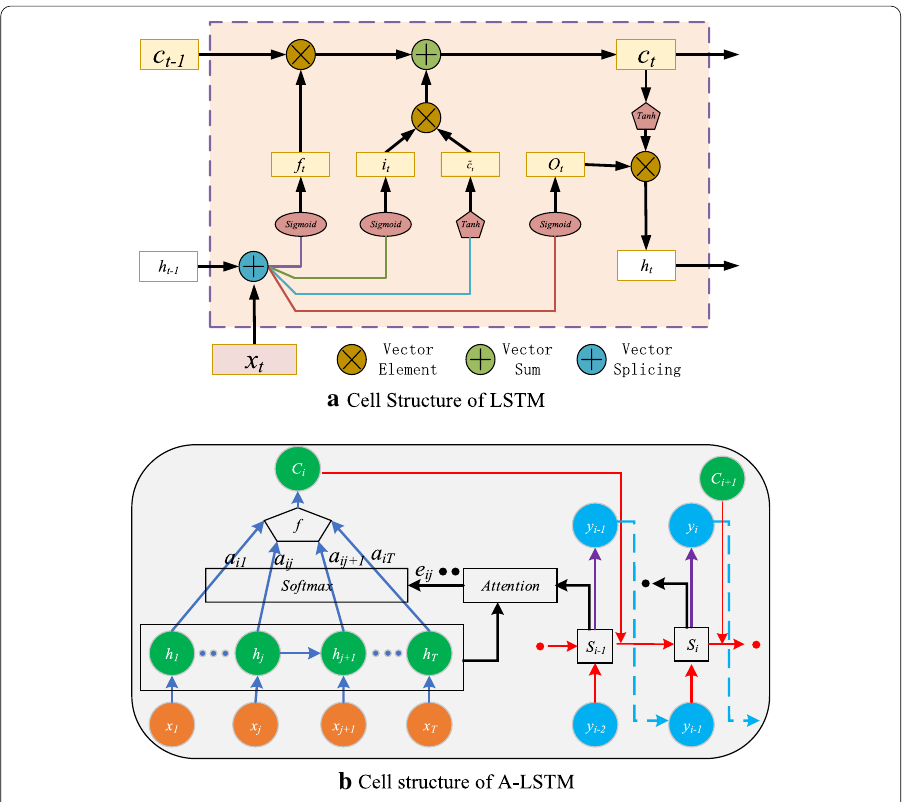
Fig. 3 Structure of